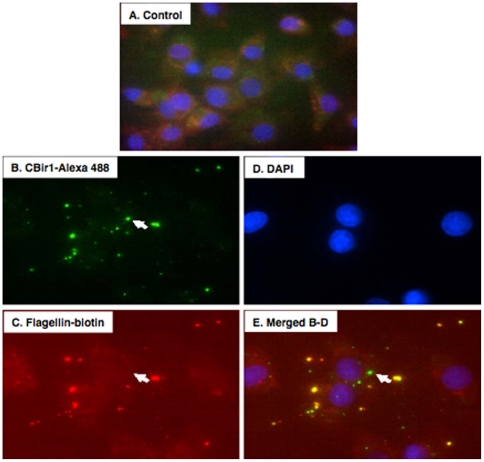
Flagellin is taken up by rat IEC monolayers.
A. Control IEC-18 cells that were not exposed to CBir1 flagellin. B and C. Following a 2 h incubation, CBir1 was internalized by IEC-18 cells as detected flagellin labeled with Alexa-488 (green) and biotin. E represents merged images of B-D showing the dual stained flagellin as visualized by fluorescent microscopy. Cell nuclei were stained with DAPI (blue).